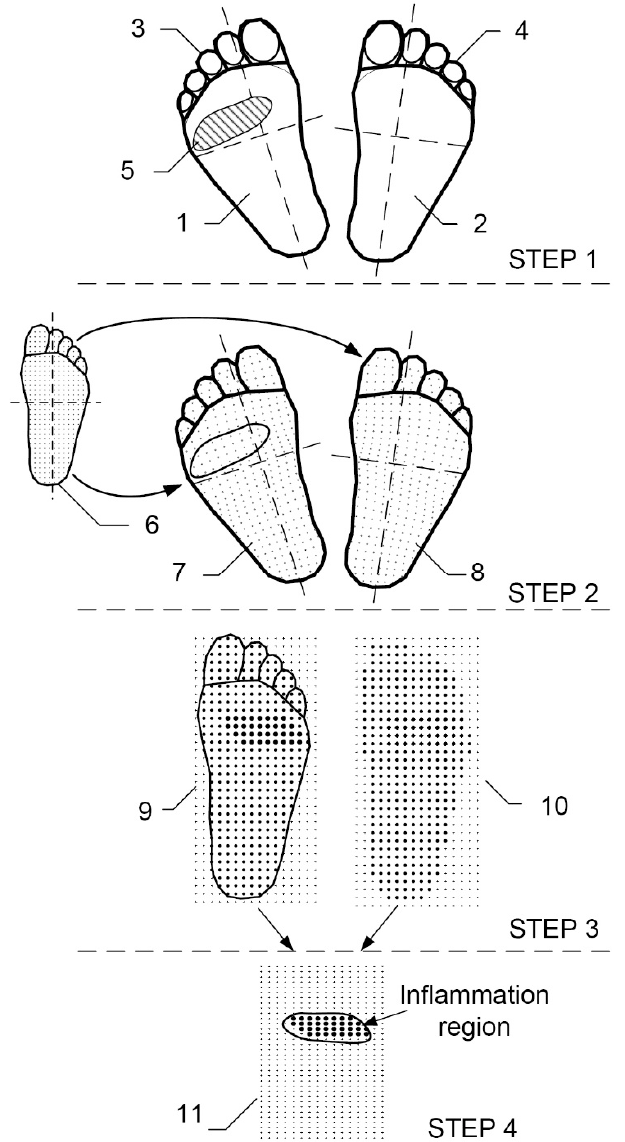
Figure 5. Automatic detection of potential inflammation regions: (1) inspected foot; (2) contralateral foot; (3) inspected foot with fitted template; (4) contralateral foot with fitted template; (5) inflammation region; (6) base foot template with initial grid; (7, 8) inspected and contralateral feet templates with adjusted grids; (9, 10) inspected and contralateral feet temperature maps; (11) temperature difference map.